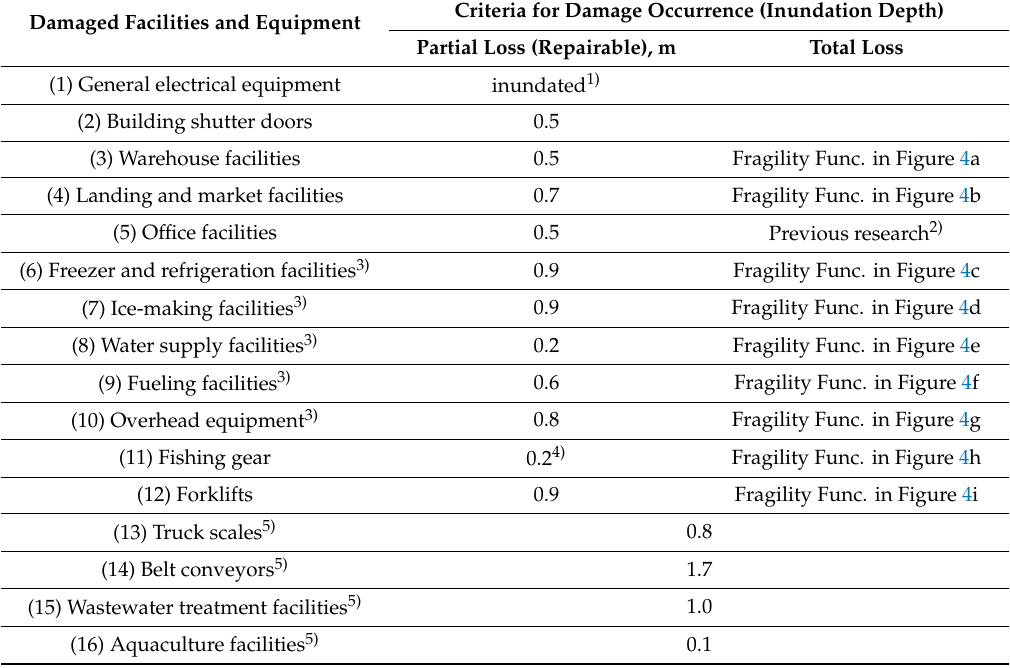
Table 1. Fishery port facility and equipment damage criteria in Japan.